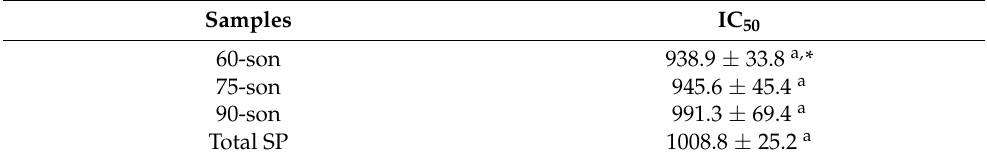
Table 1. Radical-scavenging effect (IC 50 ) of micellar dispersions.